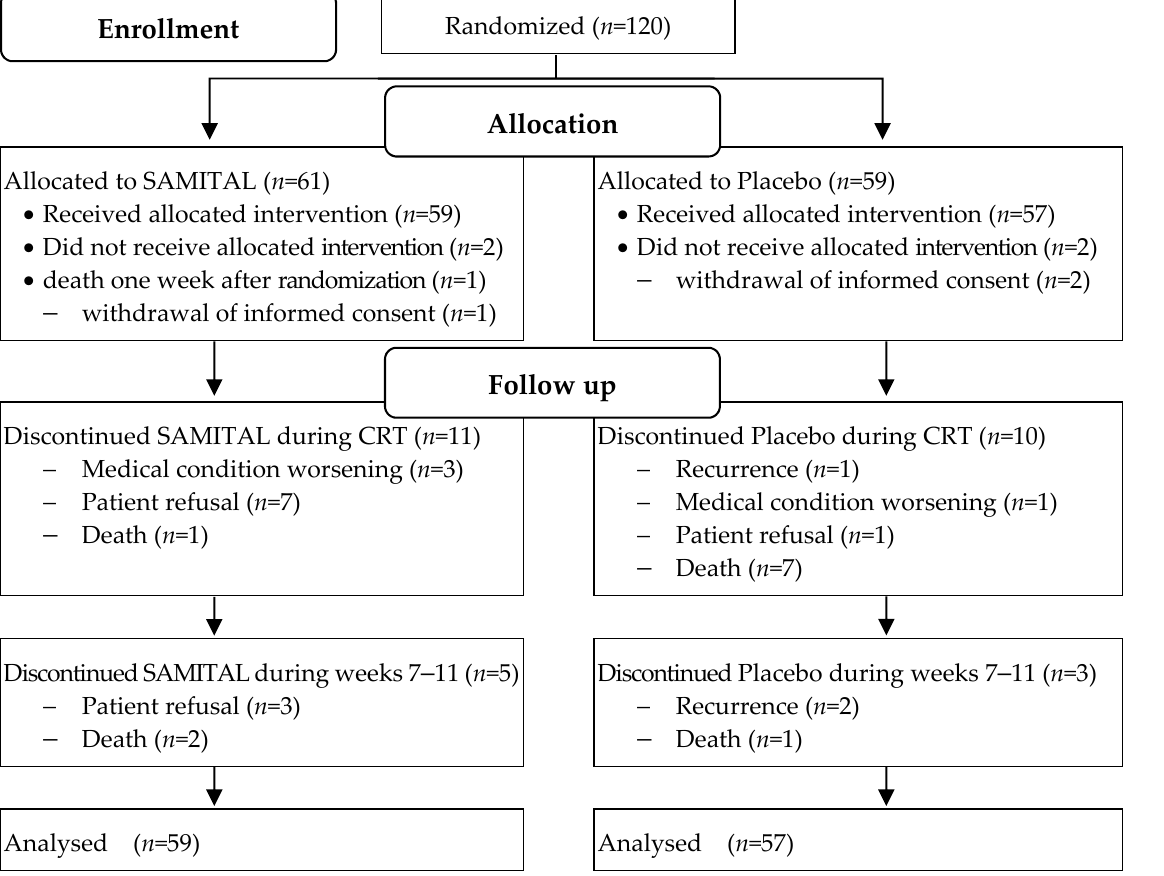
Table 1. Clinical and cancer treatment characteristics by the randomized arm.